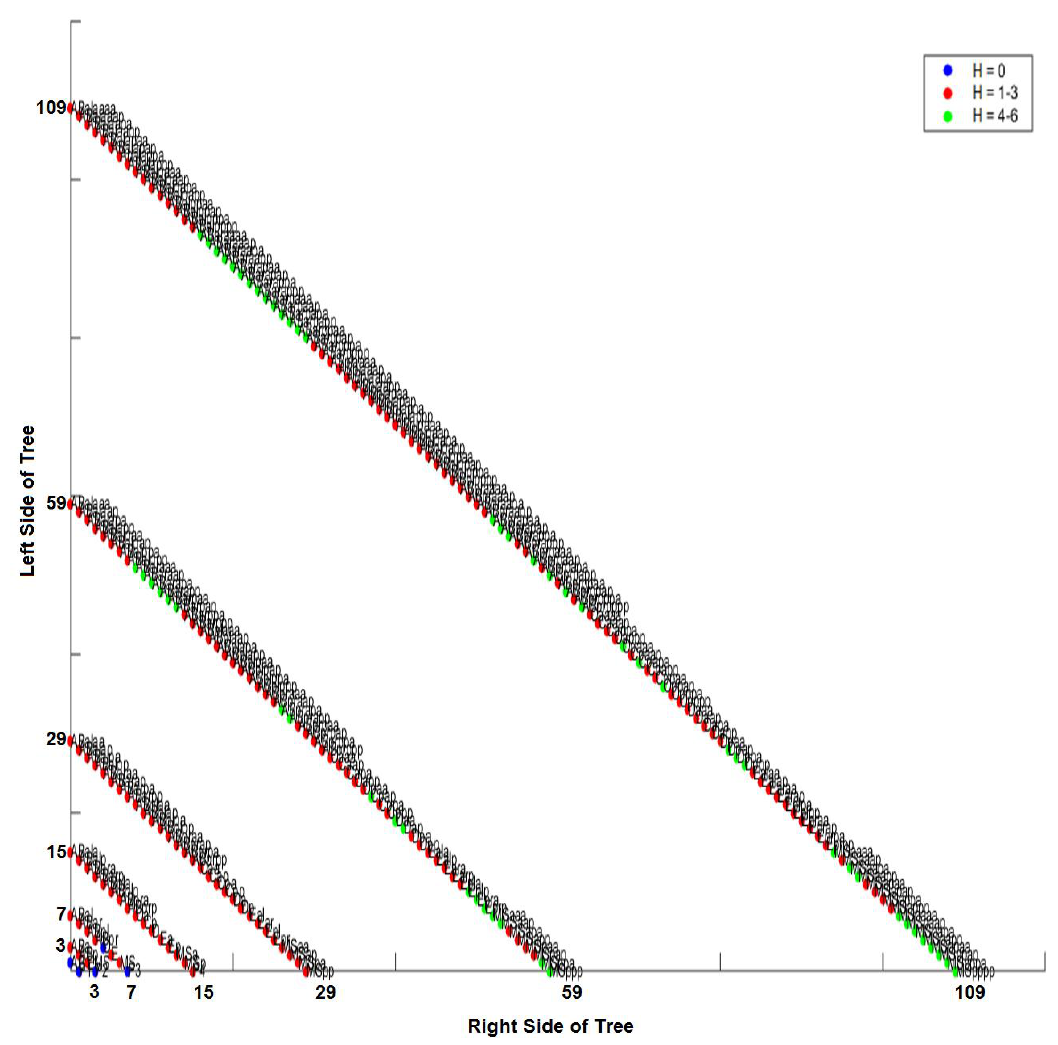
Figure 12. An isometric graph showing the Hamming distance of the differentiation tree from the lineage tree in C. elegans (N = 230). The H abbreviation stands for Hamming distance. The position of a point representing a cell is based on the depth of its node in the differentiation tree. The positions of all points are rotated 45 degrees clockwise from a bottom-to-top differentiation tree ordering (where the one-cell stage is at the bottom of the graph). Each cell is colored with its Hamming distance. See the legend of Figure 11 for other details.